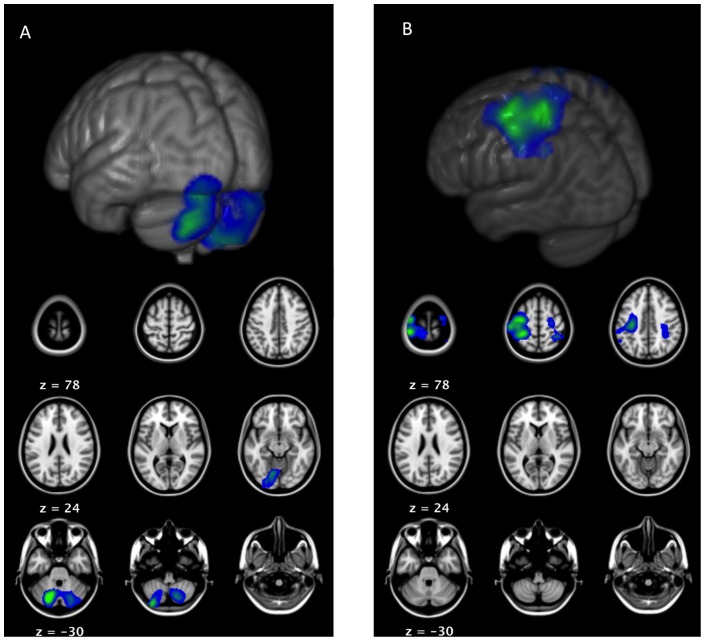
Results of beamformer analysis for beta band time frequency window (15–25 Hz, 200 to 600 ms post speech onset).The ANOVA of the source images shows (i) a main effect of condition localized to bilateral cerebellum, right fusiform and lingual gyri, and posterior cingulate cortex related to meaningful trials (A); and (ii) a main effect of response localized to bilateral motor and somatosensory areas and related to the additional motor control required for hand movement during the co-speech gesture responses (B).